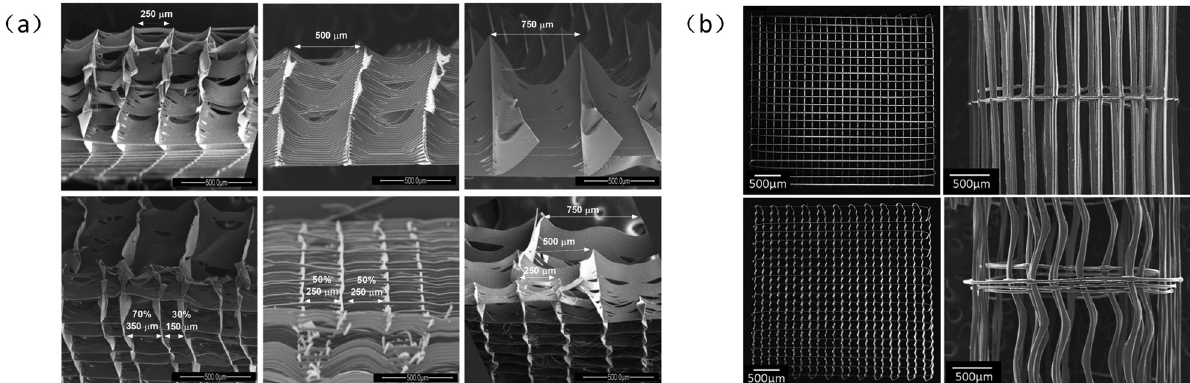
Figure 17: ( a ) The brackets with six square holes: from top to bottom, from left to right, the brackets with hole sizes of 250, 500, and 750 μ m in sequence, the o ff set brackets with 30 and 50% o ff set between layers and three di ff erent gradient sca ff old with a pore size ( 250/500/ 750 μ m ) . Reproduced from ref. [ 184 ] with permission from American Chemical Society. ( b ) Images of straight fi ber and curved fi ber sca ff olds. Reproduced from ref. [ 178 ] with permission from Elsevier